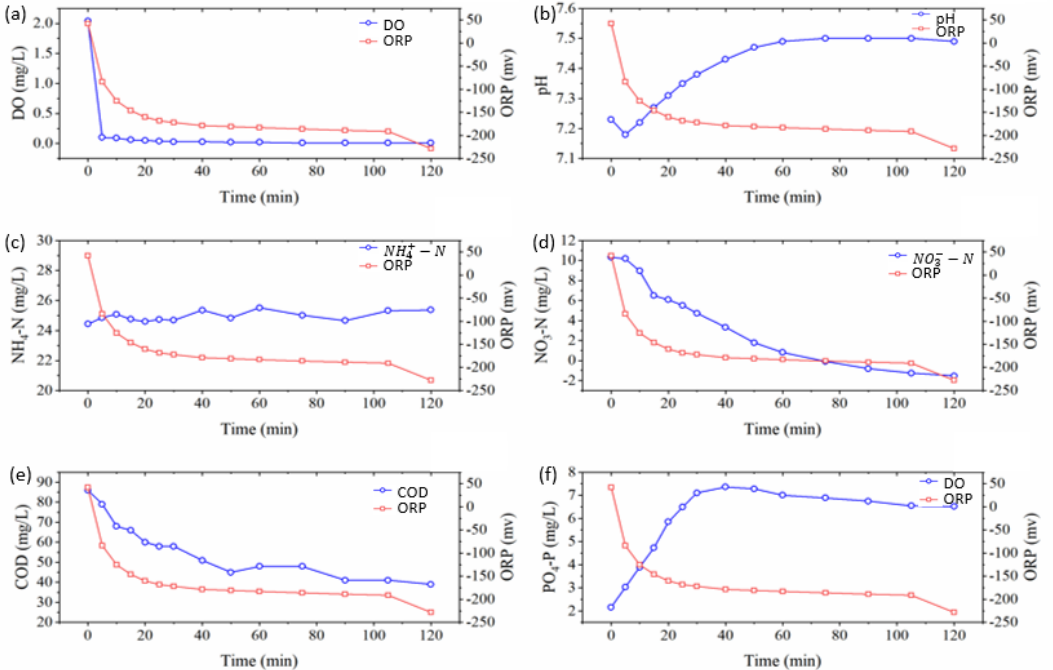
Figure 3. Variation in the ORP value together with water quality variables. ( a ) DO; ( b ) pH; ( c ) NH 4 -N; ( d ) NO 3 -N; ( e ) chemical oxygen demand (COD); ( f ) PO 4 -P.